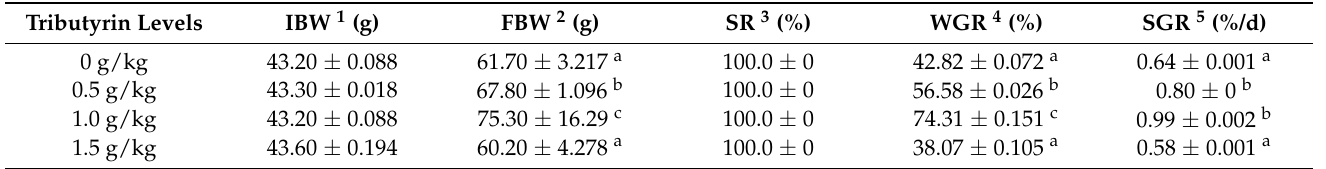
Table 3. Effects of different levels of dietary TB on growth performance parameters of grass